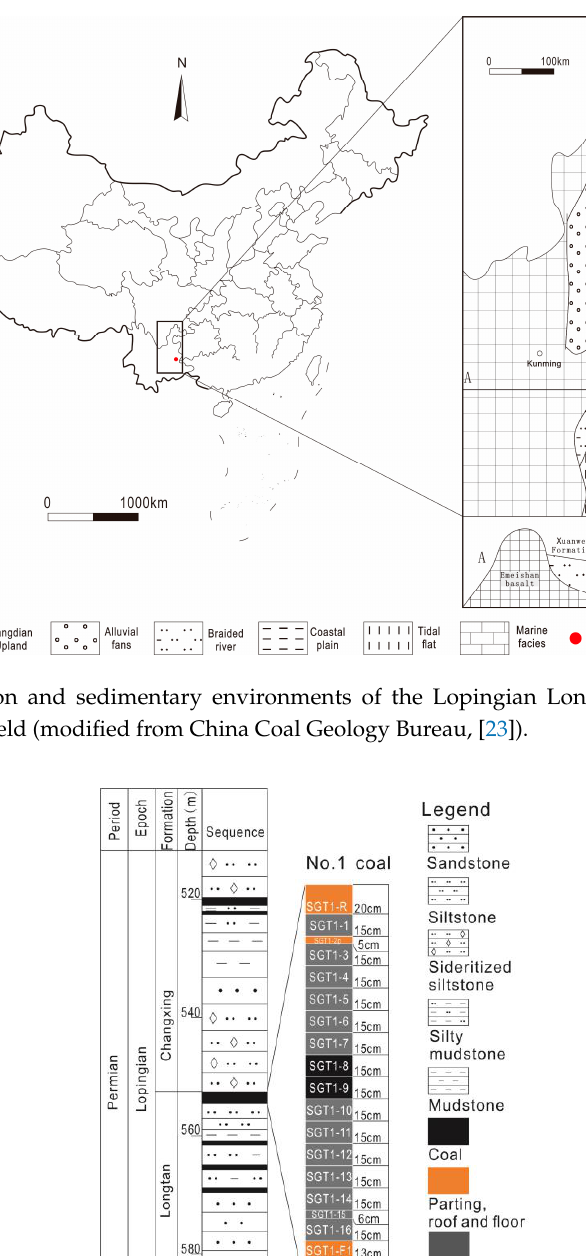
Figure 2. Sedimentary sequences of the 201 drill-hole in Shugentian Coalfield.